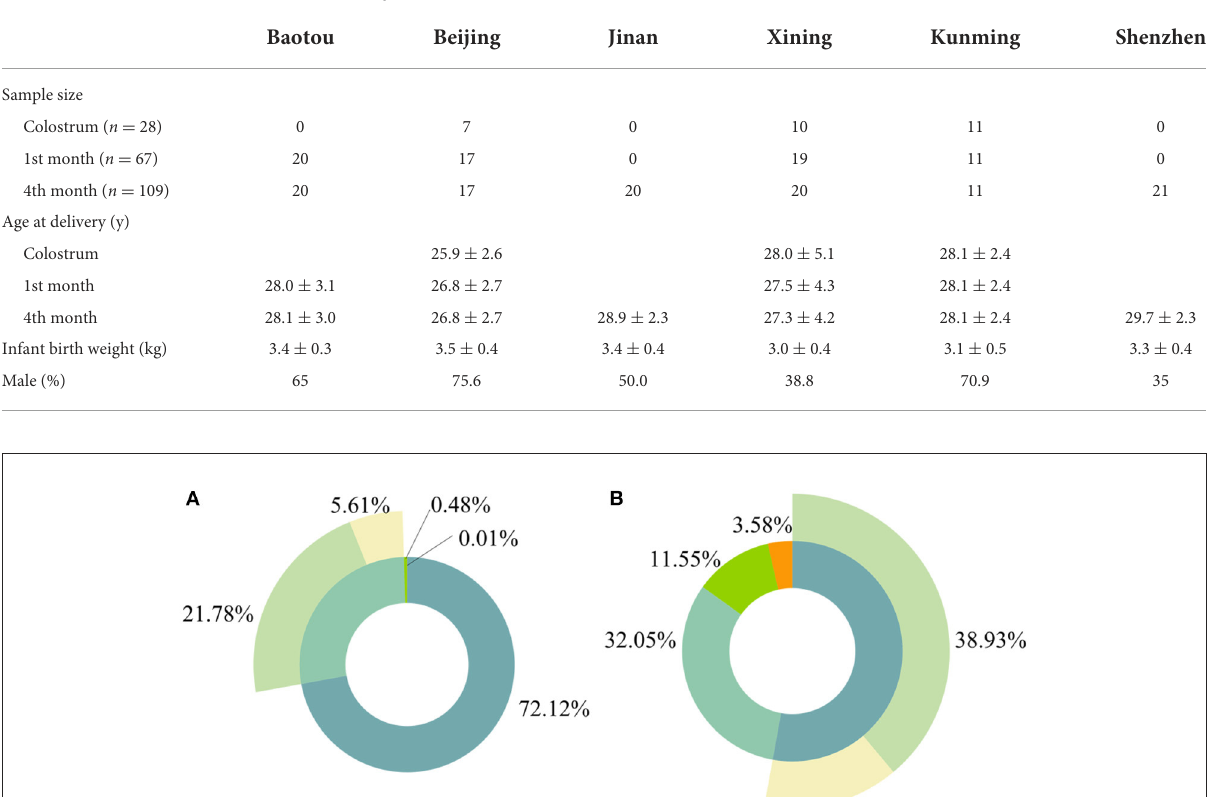
TABLE 1 Basic information of human milk samples collected from six cities in China.